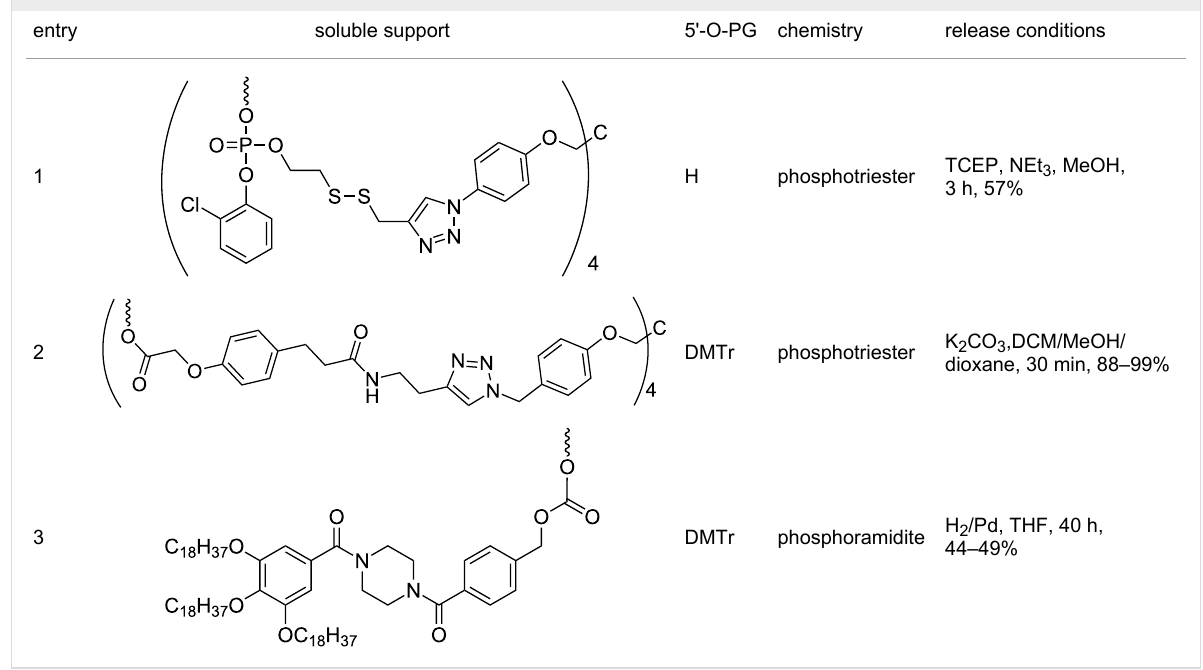
Table 1: Assembly of trimers on soluble